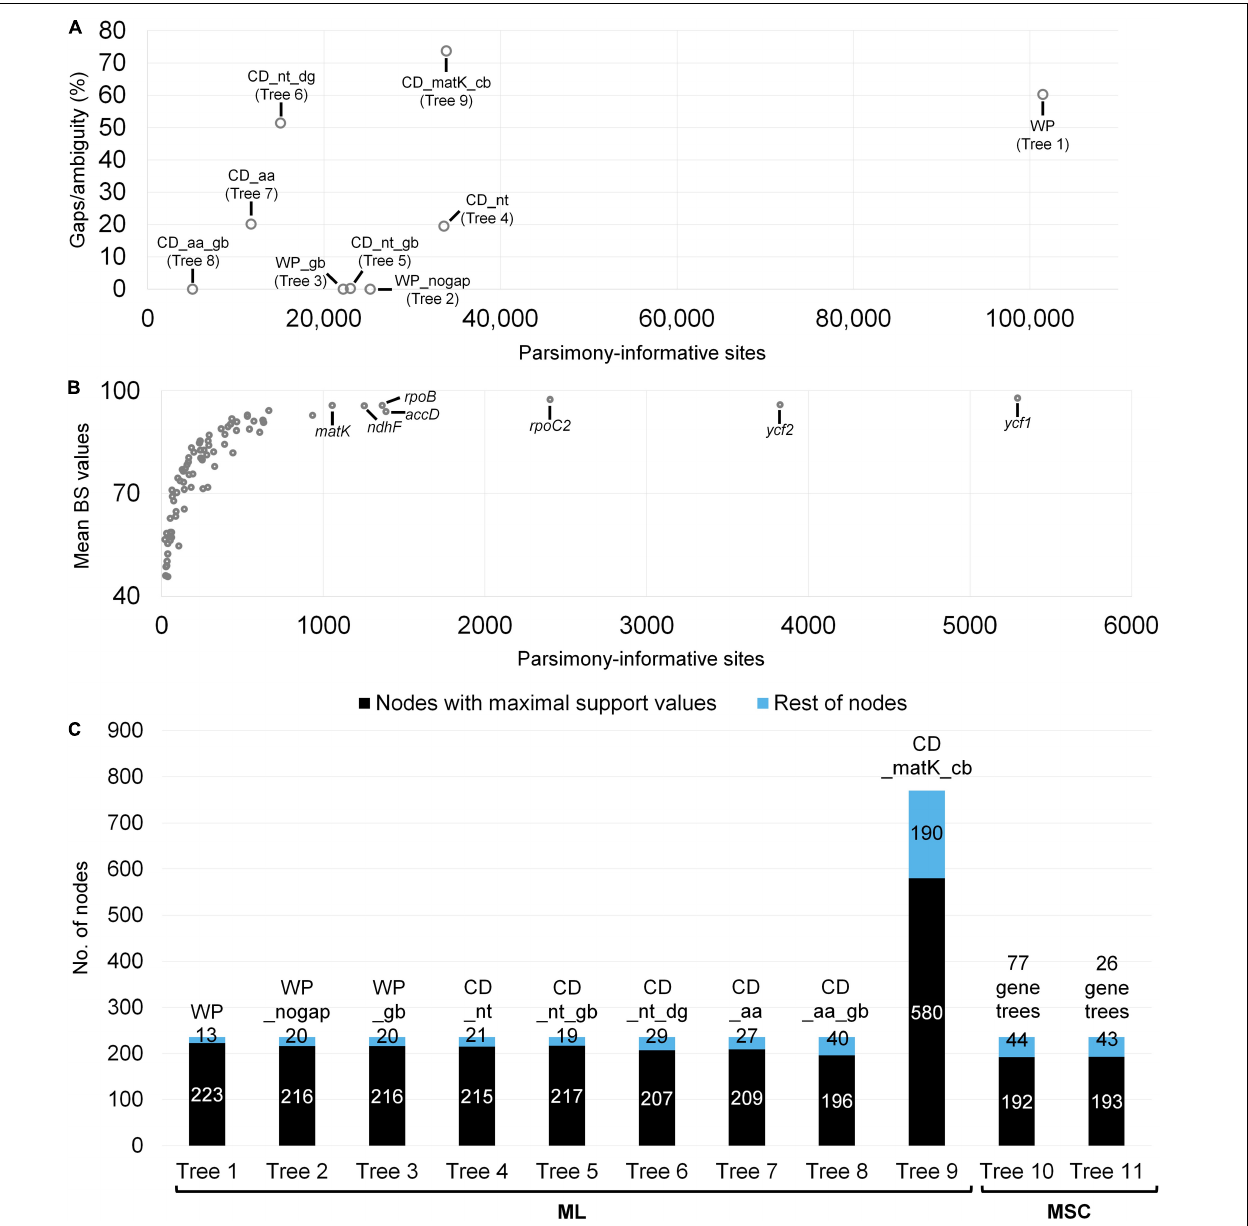
FIGURE 2 | Comparison of datasets used for phylogenetic analyses and their resolution in resulting trees. Descriptions for these datasets provided in Table 1 . (A) A scatter plot showing differences in number of parsimony-informative sites (PIS) and gap/ambiguity among datasets for maximum likelihood (ML) analysis. (B) A scatter plot showing PIS and mean bootstrap values (BS) of 77 individual gene trees that were used for the multispecies coalescent (MSC) approach. The top seven protein-coding regions (including matK ) with PIS ( > 1,000) are indicated. (C) A comparison of tree topology resolutions. Values within the histograms indicate the number of nodes. Maximal support values are BS = 100 or local posterior probability =